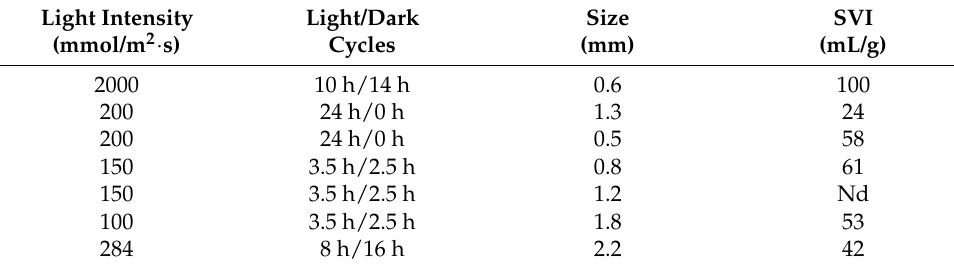
Table 2. Sedimentation properties and size of biogranules in relation to illumination [60]. Light